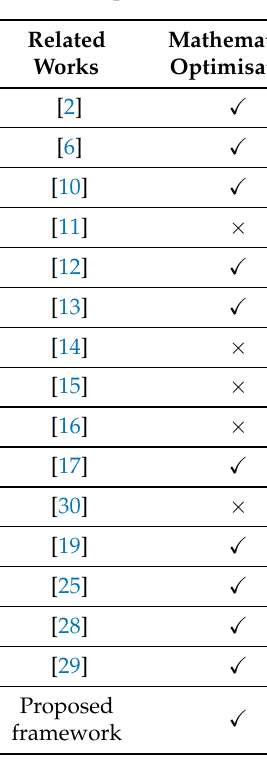
Table 1. Comparison of related works against the proposed